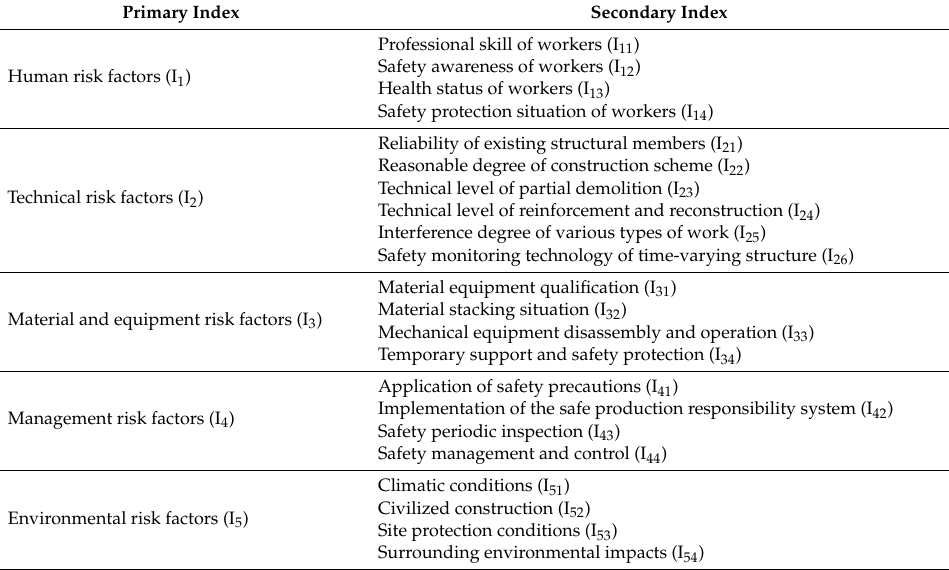
Table 1. Construction safety risk assessment index system for existing building renovation